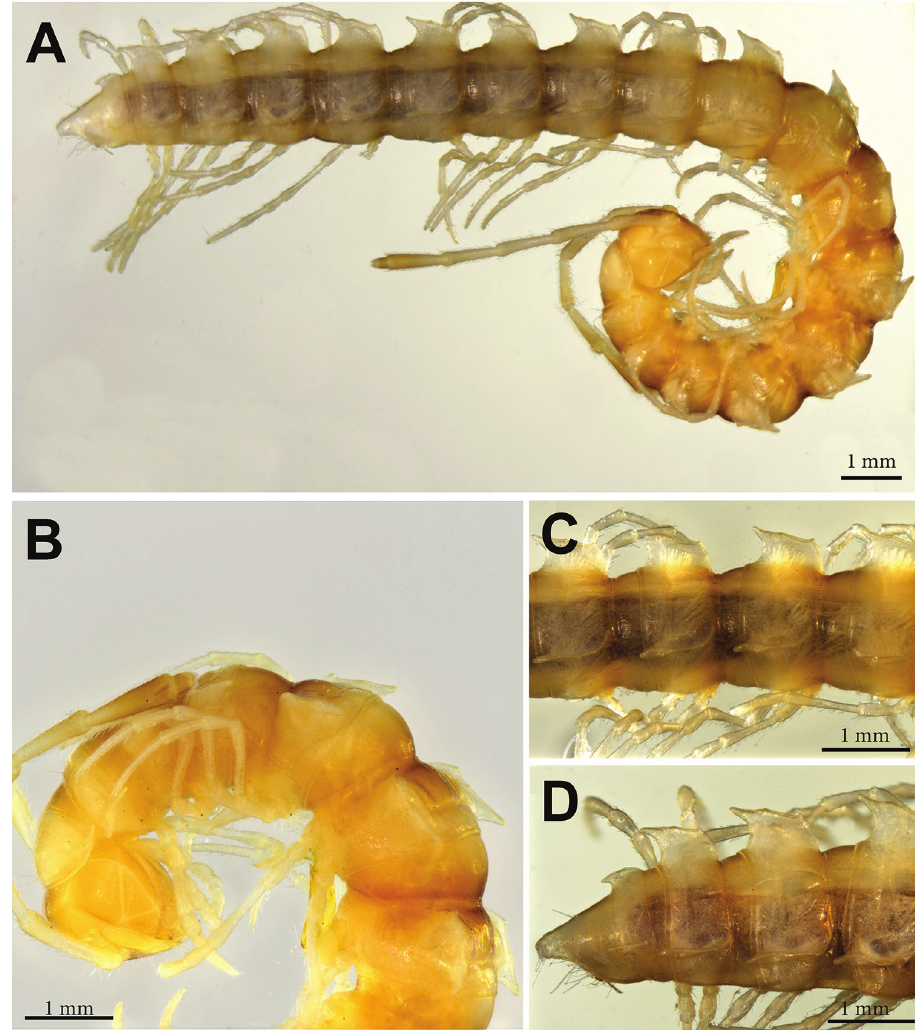
Figure 5. Annamina attemsi sp. n., ♂ paratype (NHMW). A habitus, lateral view B anterior part of body, lateral view C midbody segments, dorsolateral view D caudal part of body, dorsolateral